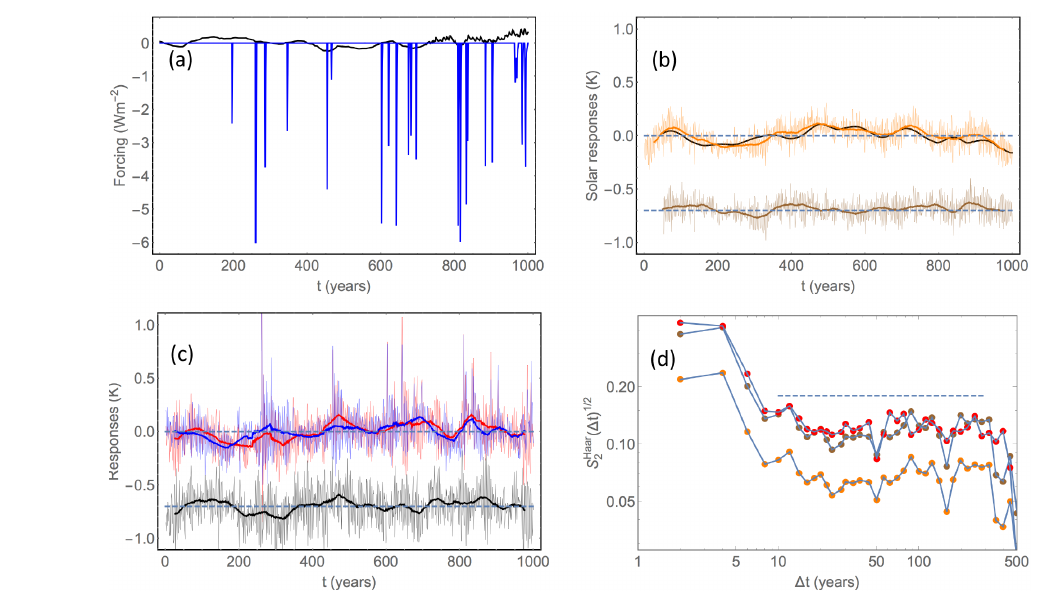
Figure 1. (a) Time series of the solar (black) and volcanic forcing (blue) for the last millennium used in the simulations of the ZC model. (b) Responses after averaging over 100 realisations. The thin orange curve is response to solar forcing; the thick orange curve is filtered by a 50-year moving average. The thick black curve is the filtered and shifted solar forcing signal (cid:49)T det s ( t,(cid:49)t ) given by Eq. (8). The thin brown curve is the internal noise (cid:15) ( t ) defined in Eq. (9), and the thick brown curve is the filtered time series. (c) The thin blue curve represents T s+v ( t ), the thin red curve is T s ( t ) + T v ( t ), and the thin black curve is their difference ε ( t ) = T s ( t ) + T v ( t ) − T u+v . Thick curves are the corresponding filtered series. (d) Haar structure function of (cid:15) ( t ) (orange bullets), of ε ( t ) (red bullets), and of